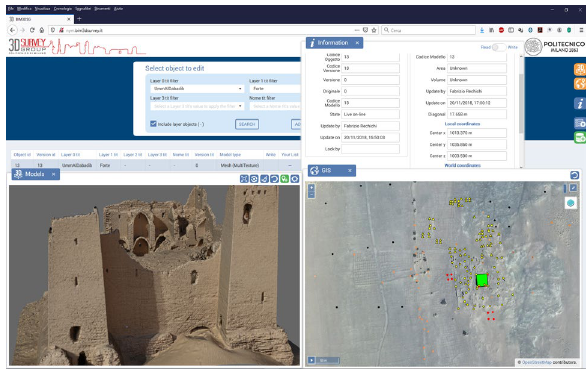
Figure 9 – Chimera’s system for Umm al-Dabadib; it is shown the Fort, a detail of the GIS area, through satellite images, and information component.